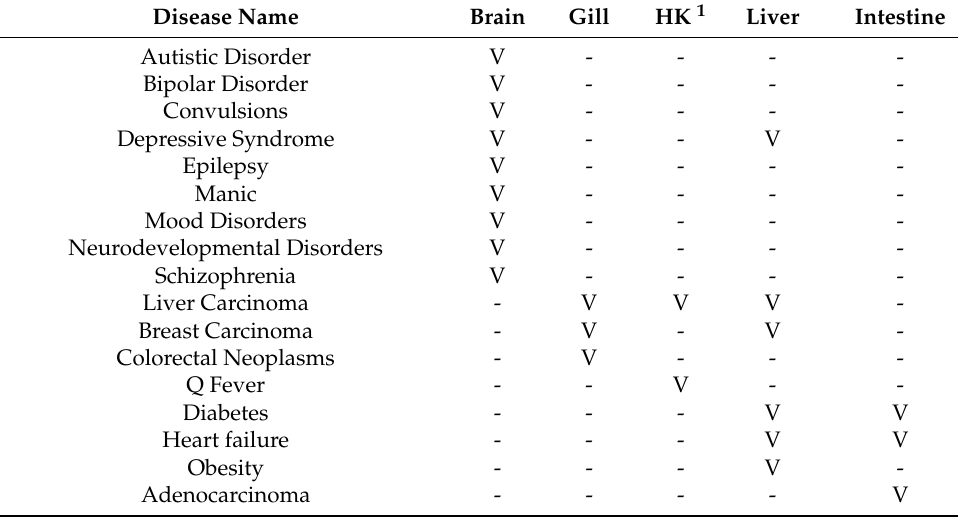
Table 6. Human diseases related to the GO analysis in common carp.